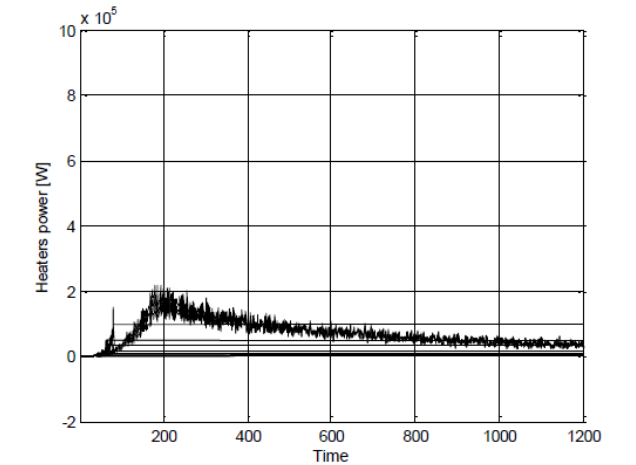
Fig. 25. Heaters power profile of trajectories belonging to cluster 3.